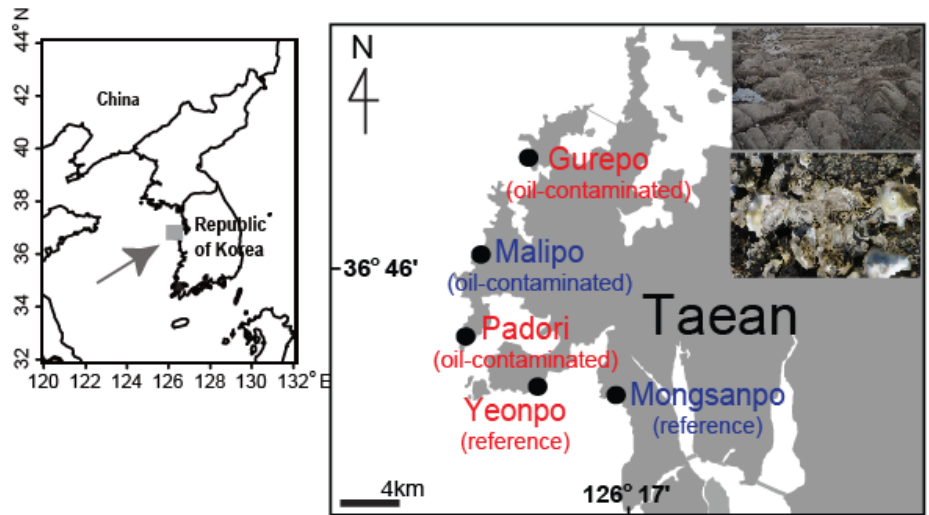
Figure 1. Map of the Taean peninsula on the western coast of Korea. Sampling areas (this study, red color) are located at two heavily oil-impacted sites (Gurepo and Padori) and one non-impacted reference site (Yeonpo). Blue color indicates the sampling sites (Malipo and Mongsanpo) investigated by [17].